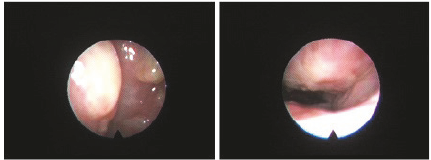
Figure 1: Fiberoptic endoscopic examination of the left nasal cavity shows diffusely whitish exudates coating on the mucosal surface.